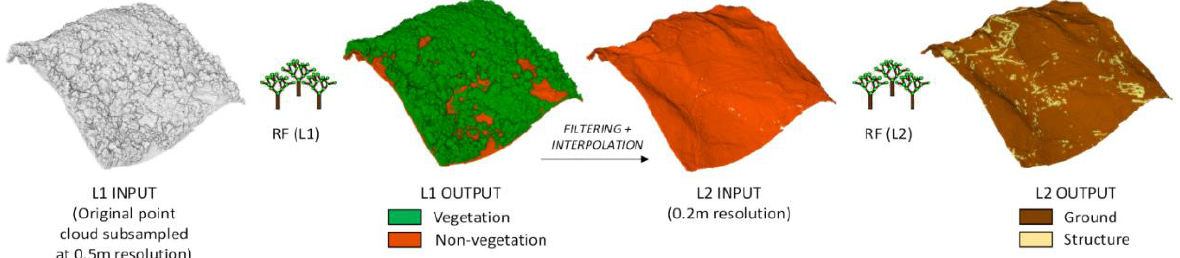
Figure 4. Supervised segmentation approach using a Random Forest (RF) algorithm at two different level of resolution (L1, L2): Dataset_1 ( San Martino ai Campi archaeological area).